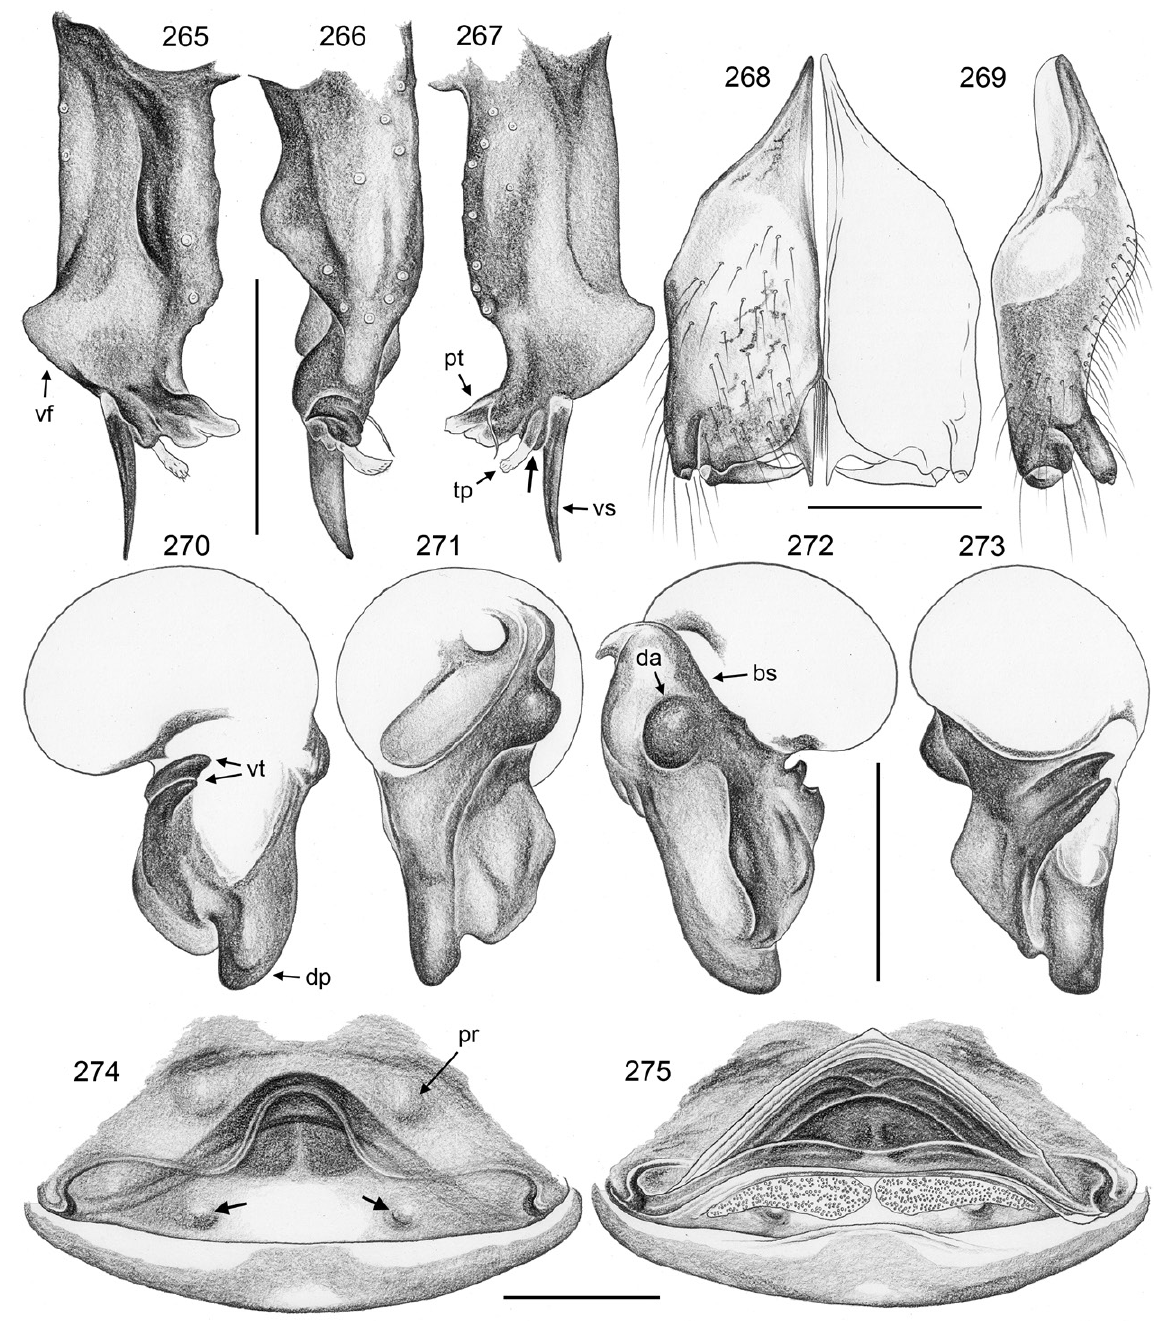
Figs 265–275. Maghreba gharbija gen. et sp. nov.; male and female from Morocco, 4 km E of Ghazoua (ZFMK Ar 22379, Ar 22380). 265–267. Left procursus, prolateral, dorsal, and retrolateral views; arrow: dark process between ventral sclerite and transparent process. 268–269 . Male chelicerae, frontal and lateral views. 270–273 . Left genital bulb, prolateral, dorsal, retrolateral, and ventral views. 274– 275 . Cleared female genitalia, ventral and dorsal views; arrows: pockets (pits). Abbreviations: bs = basal sclerite; da = dorsal apophysis; dp = dorsal process; pr = epigynal process; pt = procursus tip; tp = transparent process; vf = ventral flap; vs = ventral sclerite; vt = ventral teeth. Scale bars = 0.3